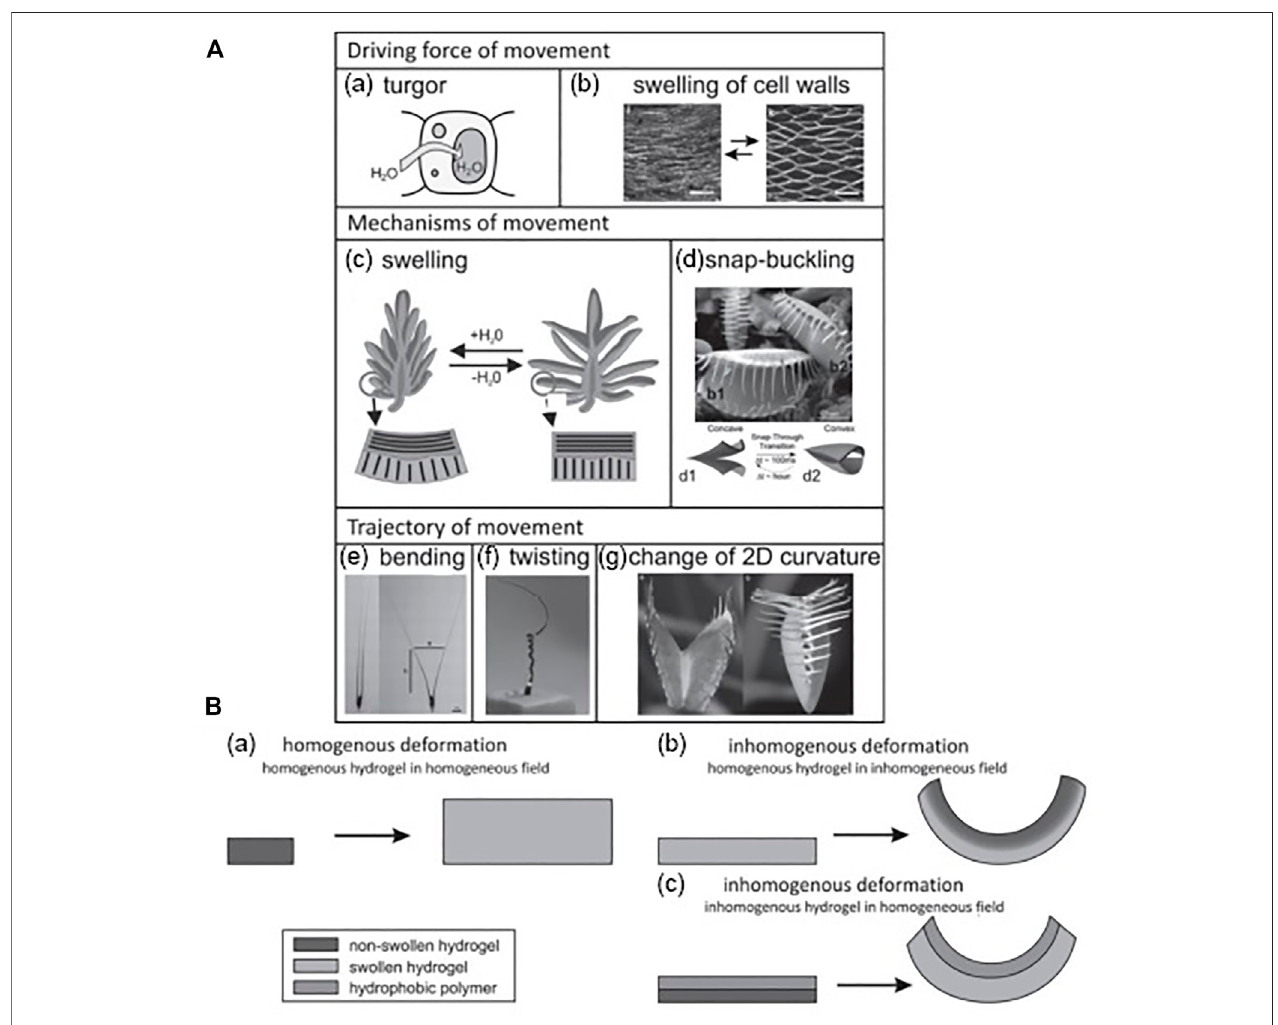
FIGURE 2 | (A) Examples of two-way movement in plants with respect to the driving force: (a – g) turgor cell wall mechanism via swelling/shirking with snap- buckling, bending, twisting, and alteration of two-dimensional (2D) curvature. (B) Various setups of swelling/shrinking of hydrogels: (a – c) homogeneous and inhomogeneousdistortionofhomogeneoushydrogelandinhomogeneousdistortionofinhomogeneoushydrogel(Maoetal.,2005;Bassiletal.,2008;Ismailetal.,2011; Takashima et al., 2012). Copyright 2013, John Wiley & Sons Inc.